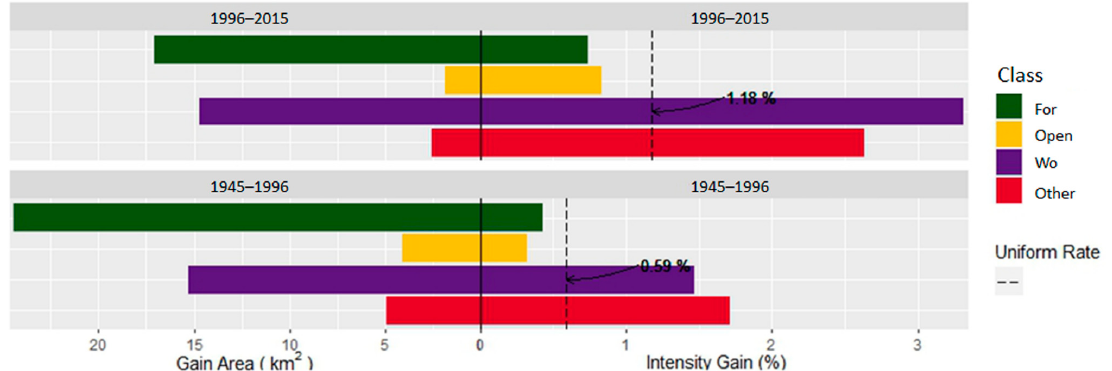
Figure 6. LULC class level intensity analysis for area gain in the study area for the 1945–1996 and 1996–2015 periods. Bars that extend to the left of zero axis show the gross surface gain for each LULC class. Bars that extend to the right of zero axis show the intensity of gain for each class. The vertical, dashed line at the right part of the plot depicts the hypothesized uniform intensity across the total landscape of the study area. Classes with bars extending beyond this line are considered as having active gains, while those with bars before that line are considered as having dormant gains.